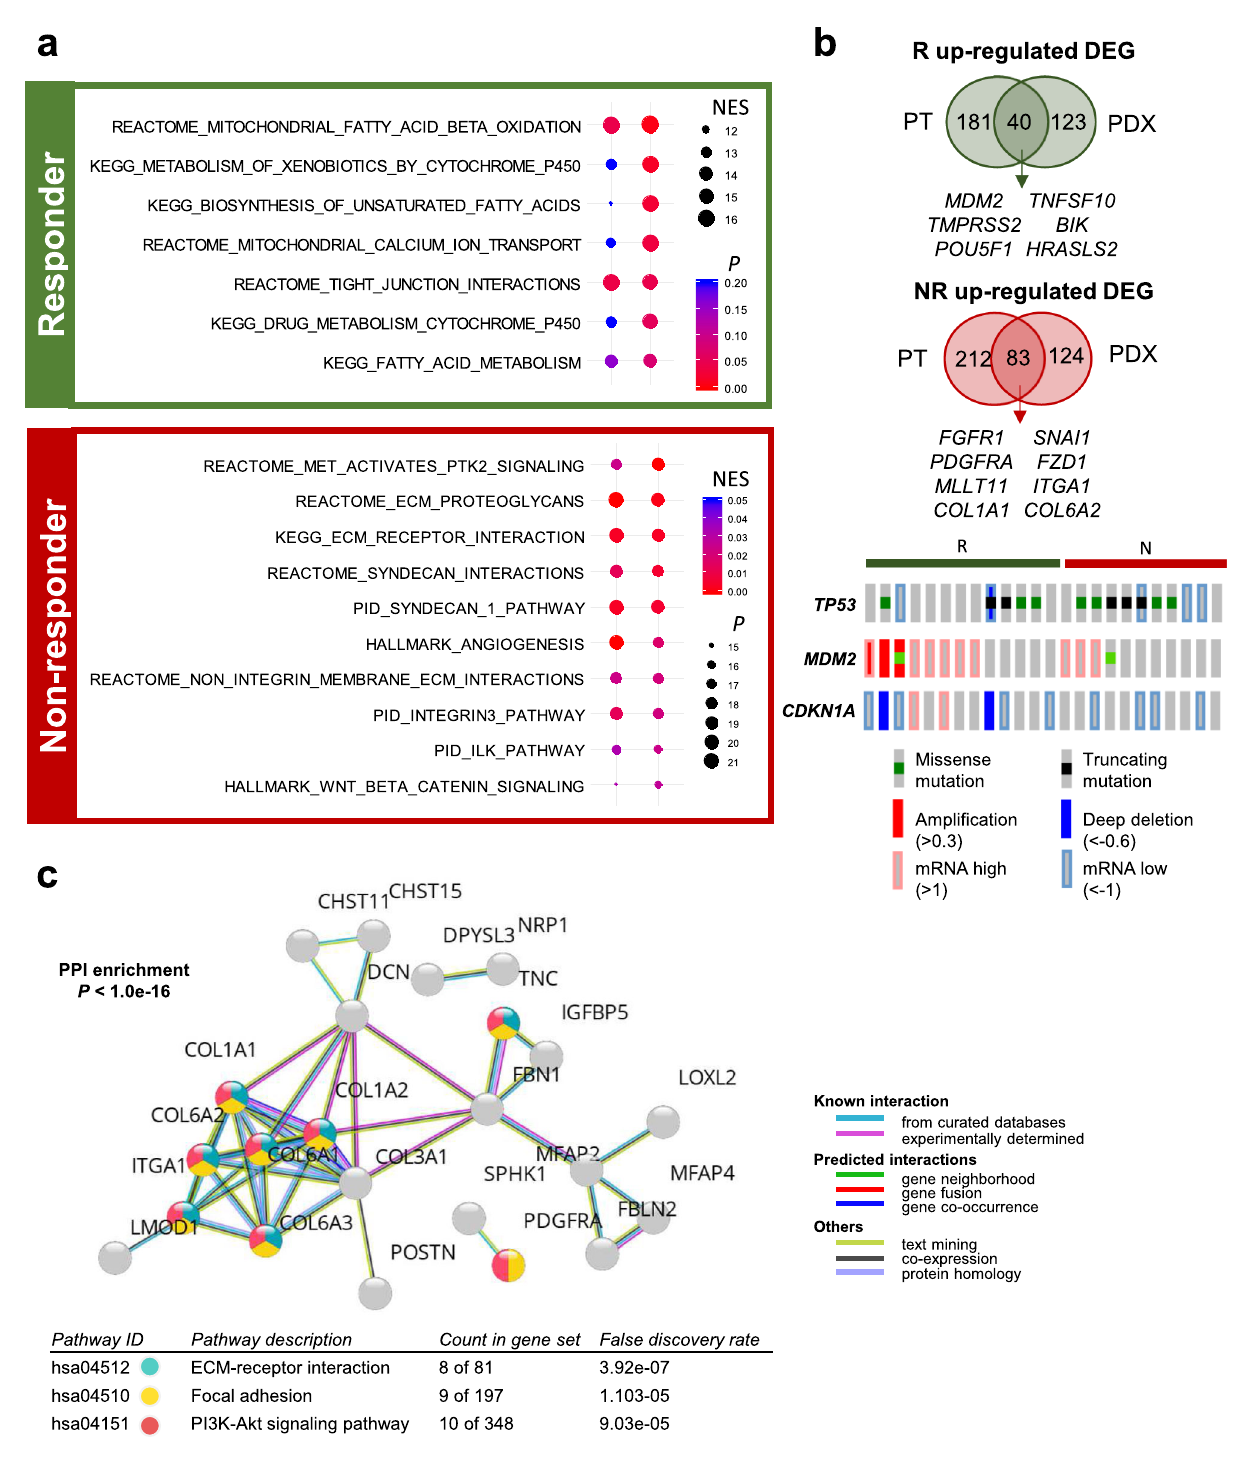
Fig. 3 Identi fi cation of response-associated gene expression features for 5-FU and oxaliplatin-based chemotherapy. a Gene set enrichment analysis (GSEA) of the R versus NR PDX models, using RNA sequencing data. GSEA demonstrated that metabolism-related pathways were enriched in the R group and Wnt/ β -catenin and angiogenesis signaling pathways were enriched in the NR group. Normalized enrichment score (NES) and nominal P value is described. b Identi fi cation of core differentially expressed genes (DEGs) between the R and NR groups in both patient tumors and PDX tumors (Top). A total of 40 upregulated genes were identi fi ed in the R group and 83 upregulated genes were identi fi ed in the NR group. The bottom panel shows the genetic and transcriptomic alterations in TP53 -associated genes in the R and NR groups. c Protein – protein interaction enrichment analysis based on STRING network for the 83 DEGs that are upregulated in the NR group. Enrichment P value are corrected for multiple testing using the method of Benjamini and